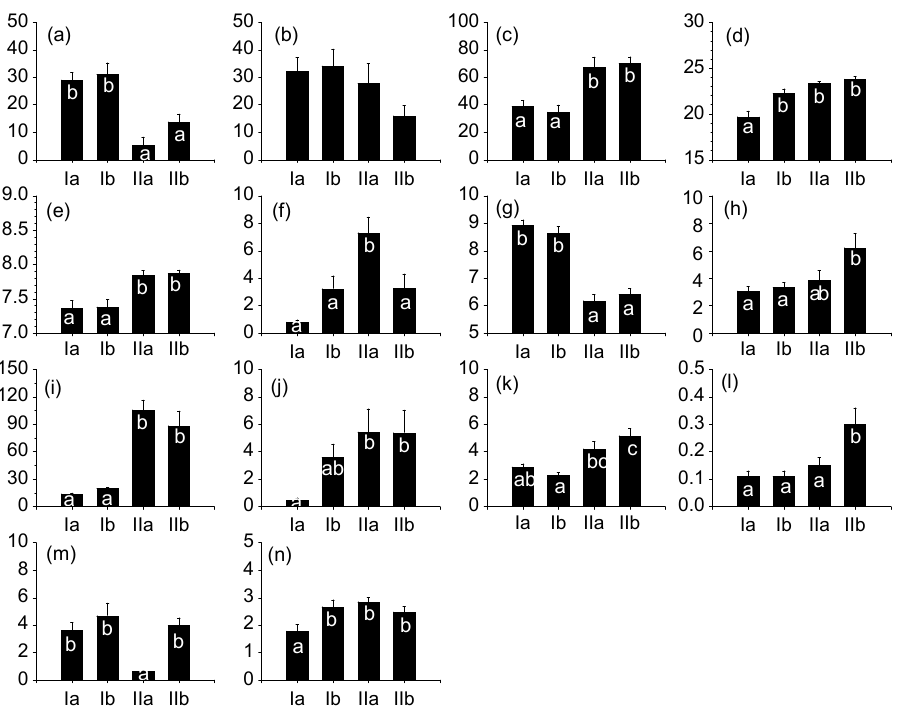
Figure 2. Environmental variables in four groups of Korean estuaries between 2012 and 2014. Small letters (a, b, and c) indicate Tukey’s post hoc test values. ( a ): forest area (%); ( b ): urban area (%); ( c ): argricultural area (%); ( d ): water temperature (°C); ( e ): pH; ( f ): salinity (permille); ( g ): DO (dissolved oxygen; mg/L); ( h ): BOD (biochemical oxygen demand; mg/L); ( i ): turbidity (NTU); ( j ): Electric conductivity (1000 µ S/cm); ( k ): total nitrogen (mg/L); ( l ): total phosphorus (mg/L); ( m ): chlorophyll- a (mg/cm 2 ); ( n ): AFDM(mg/cm 2